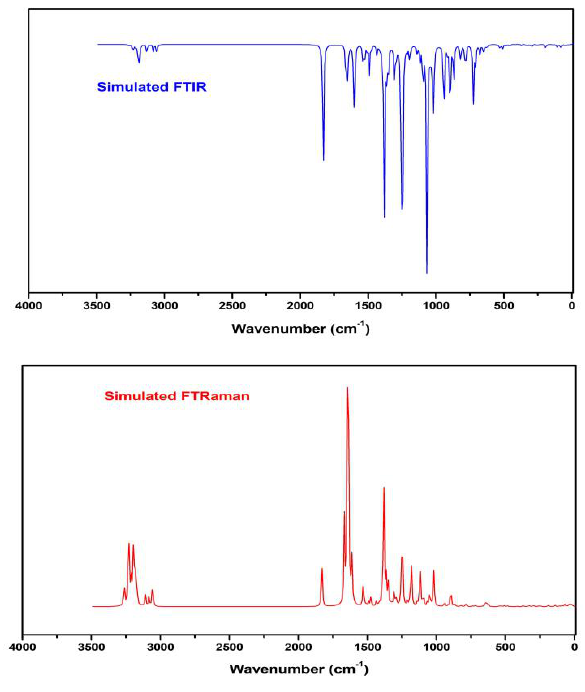
Experimental FT-IR and FT-Raman and spectra of the IPAONM molecule. Figure 8: